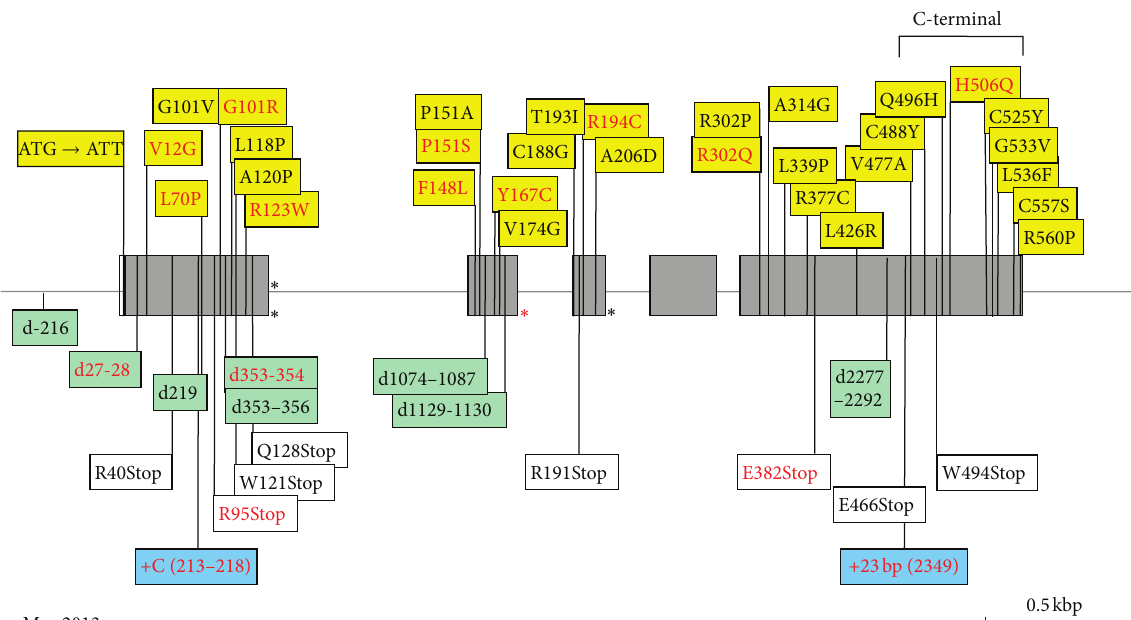
Figure 6: Mutations of the AMH gene in PMDS. Exons are shaded. All recurrent mutations are indicated in red. Missense mutations are in yellow boxes; note that the first mutation destroys the translation initiation site. Asterisks represent splice mutations; the red asterisk at the beginning of the second intron indicates a mutation detected in three different families all from Northern Europe. Deletions (marked “d”) are in green boxes, insertions (marked “+”) are in blue boxes, and nonsense mutations are in white boxes. A deletion mutation in the promoter is shown. C-terminal: coding for bioactive C-terminal domain of the AMH molecule. Base numbering is from major transcription initiation site, − 10bp from A of